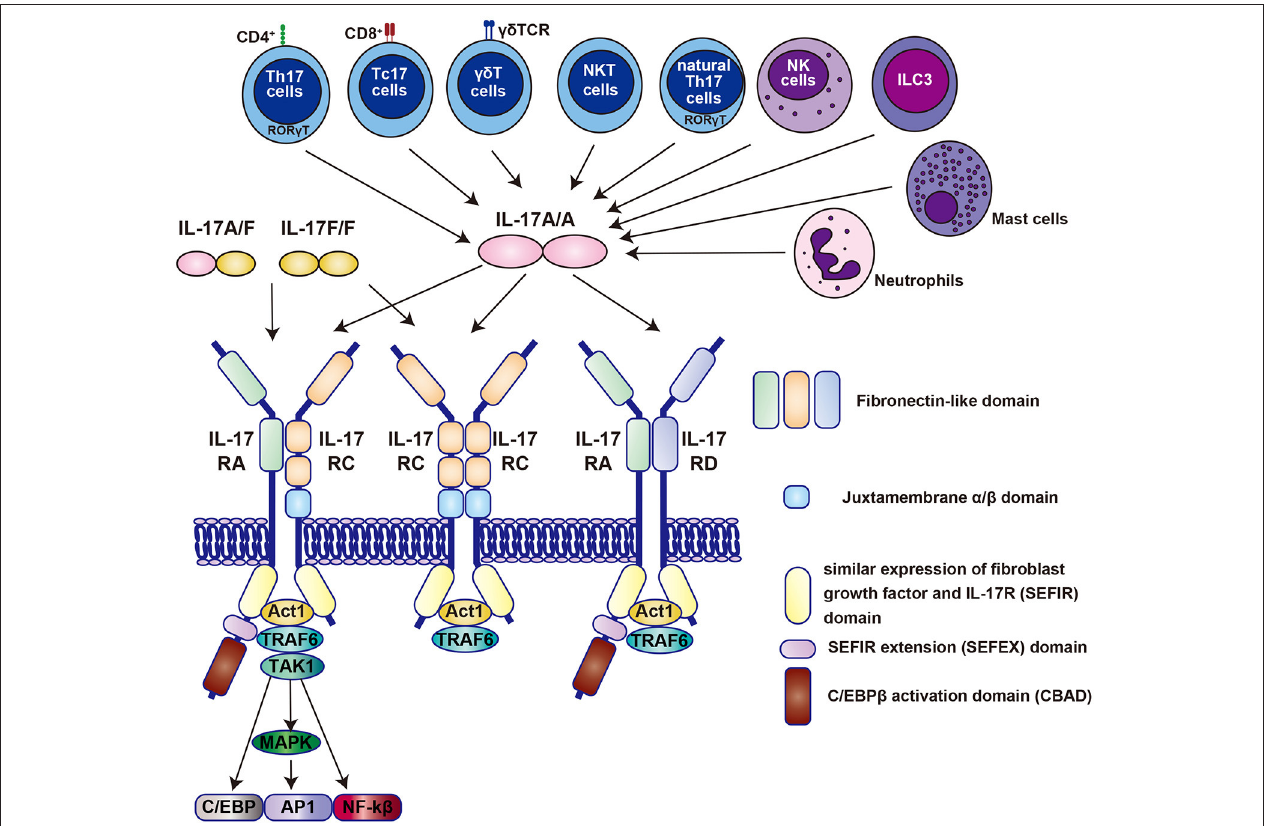
FIGURE 1 | The molecular binding system of the IL-17 family centered on IL-17A and its receptors. All the family members of the IL-17 family, except IL-17D function as homodimer, whereas IL-17A and IL-17F form a heterodimer (denoted as IL-17A/F) ( 21). All receptors also function as homodimers or heterodimers. Homodimers of IL-17A (denoted as IL-17A/A) selectively bind to specific IL-17RA/RC, RC/RC, or RA/RD receptor complexes. Contrastingly, IL-17A/F and IL-17F/F bind only to IL-17RA/RC and RC/RC receptor complexes. Each IL-17 receptor has an extracellular fibronectin-like domain that binds the ligand and an intracellular SEFIR (similar expression of fibroblast growth factor and IL-17R) domain that recruits molecules such as Act1 and TRAF6 (21). The IL-17 receptor family has been shown by Goepfert et al., to be structurally bent between the first and second fibronectin domains (22). IL, interleukin; Th17, T helper 17; Tc17, IL-17-producing CD8 + T cells; NKT, natural killer T cells; NK; natural killer cells; ILC3, type 3 innate lymphoid cells; NF, nuclear factor; TRAF6, tumor necrosis factor receptor-associated factor 6; MAPK, mitogen-activated protein kinase; TAK1; transforming growth factor- β -activated kinase